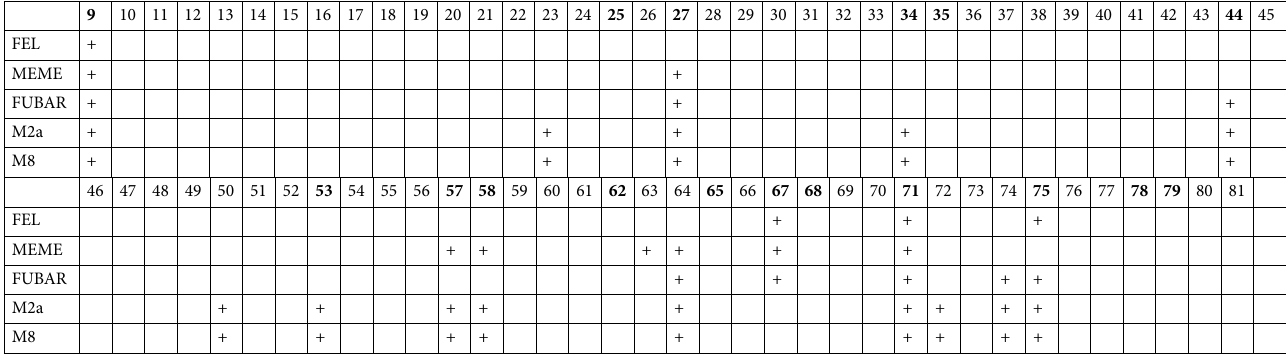
Table 3. Identification of the codons in DAB1 showing the signature of positive selection predicted based on the five different models implemented RDP (using HyPhy package) and CODEML. The codons predicted to be PBR were highlighted by bold.